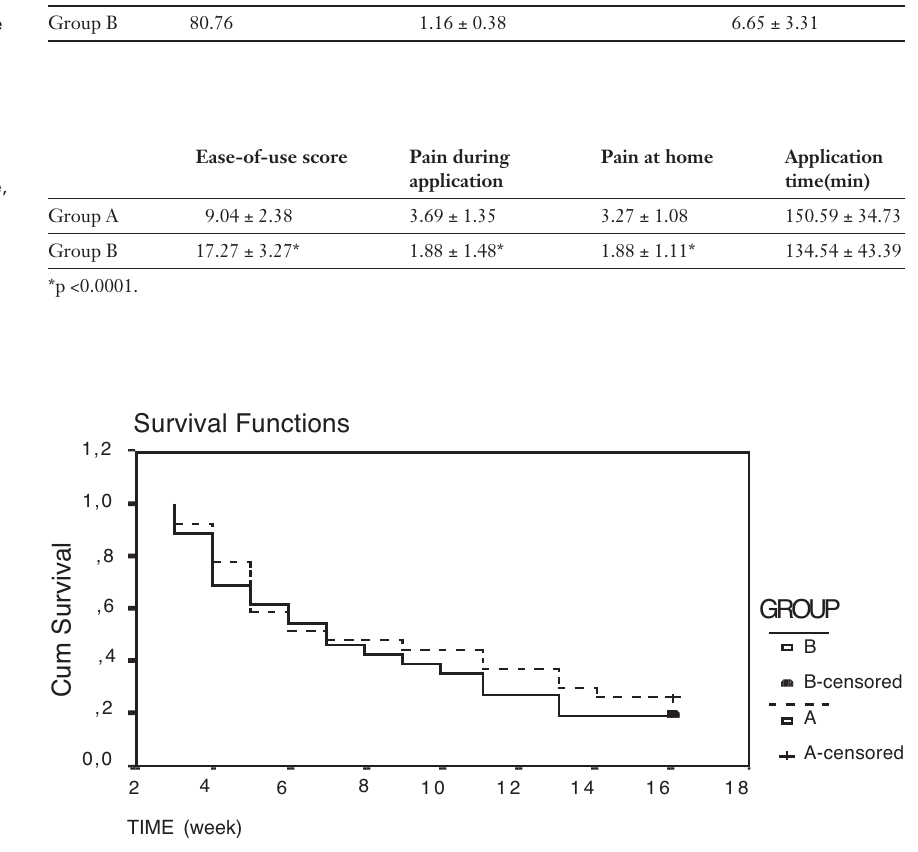
Complete healing rates, healing time, Weekly wound sur- face reduction of the treatment modality.